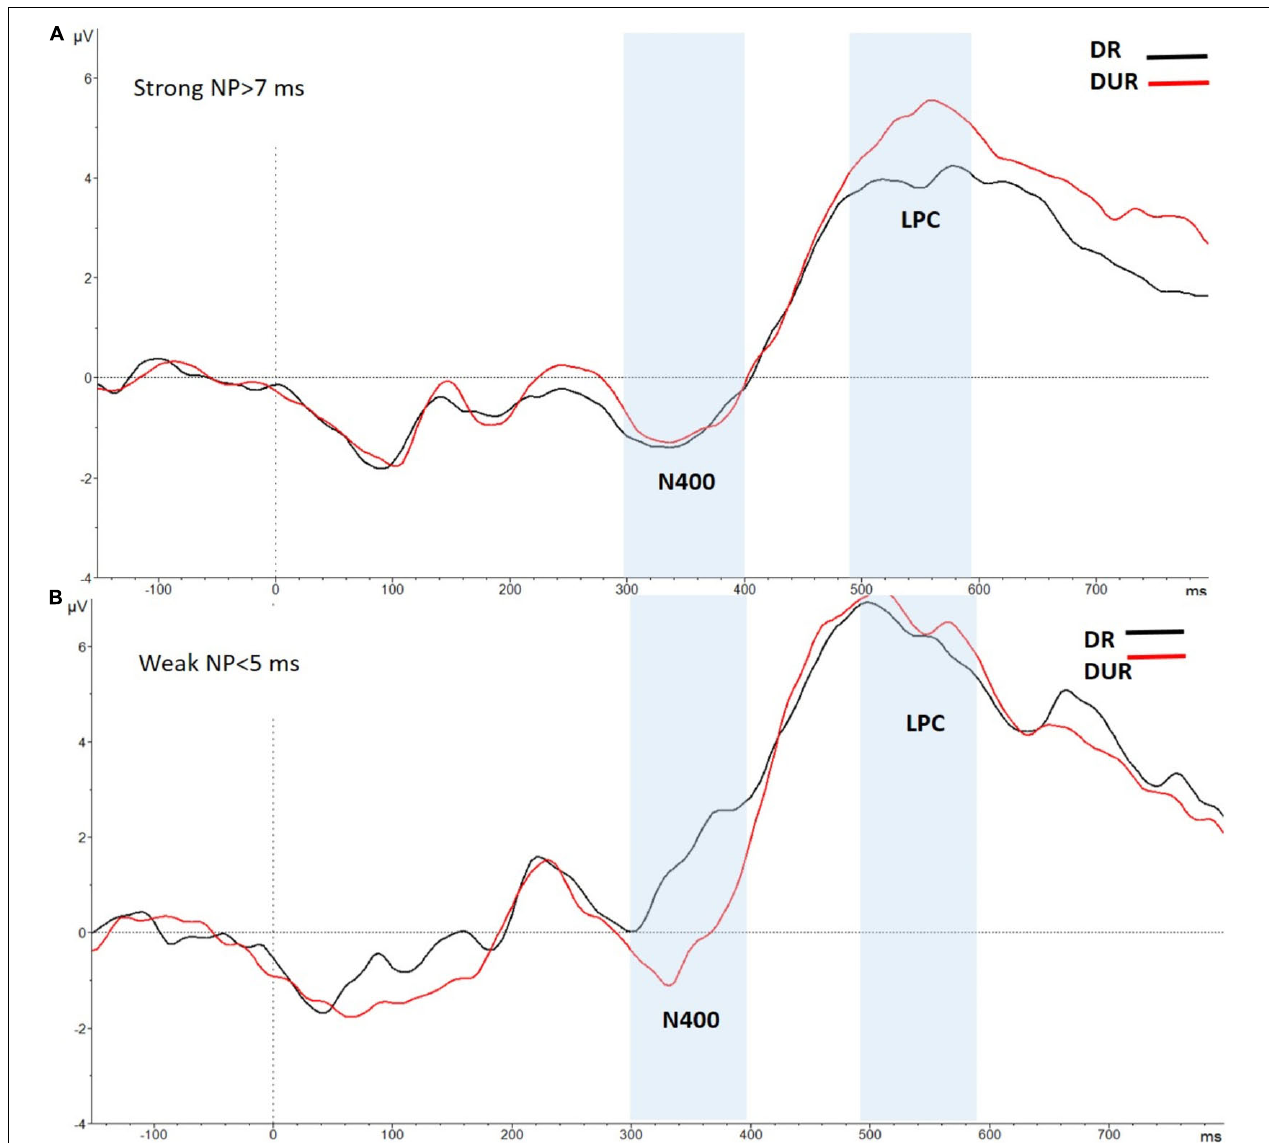
FIGURE 6 | Grand-averaged voltage data (in µ V) in the Delayed Masking condition as a function of Prime-Target Relatedness (Related-R, black line, vs. Unrelated-NR, red line) in the High WMC group, separately for participants showing behavioral NP ( A: NP effect > 7 ms; N = 19); and participants showing behavioral facilitation or weak NP ( B: NP effect < 5 ms; N = 7). Voltages were collapsed across the nine fronto-central and centro-parietal electrode sites (FC1/FC2, C3/C4, P3/P4, FCz, Cz, Pz). The analyzed epoch lasted from 150 ms before the onset of the target to 700 ms after target onset. Negative potentials are plotted downwards. Vertical gray shadings above the X -axes indicate the 300–400 ms (N400) and 490–590 ms (LPC) time windows used for statistical